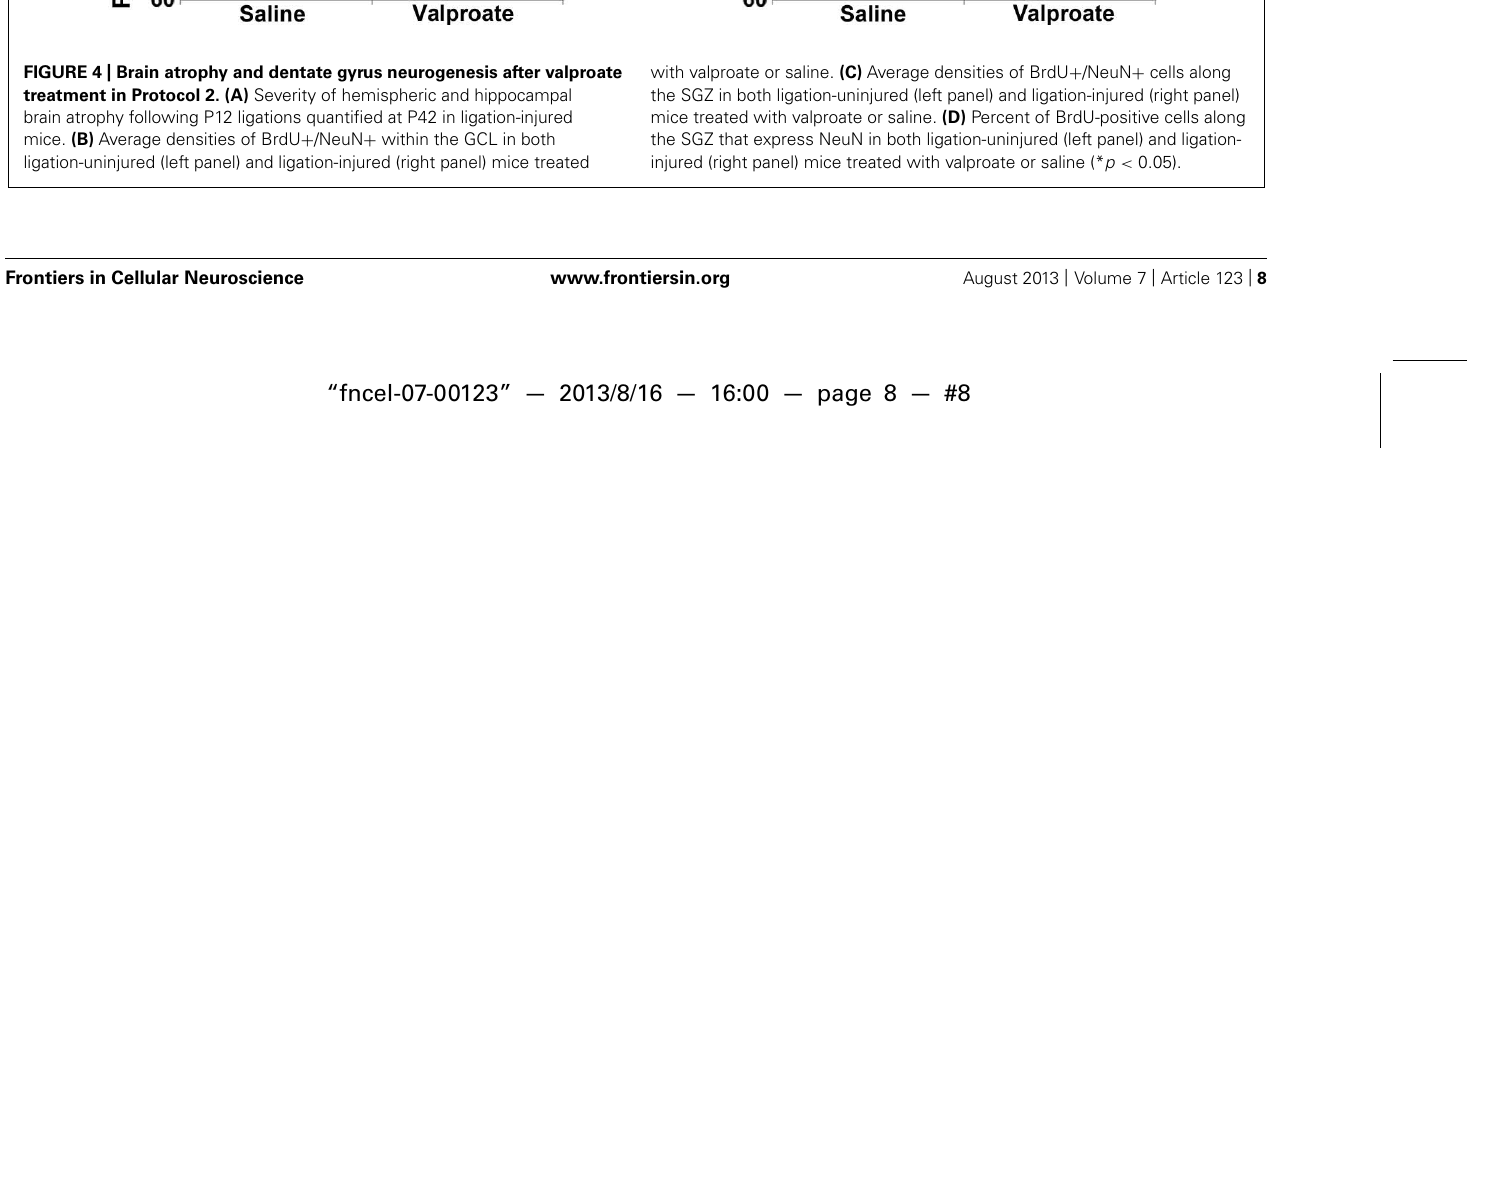
with valproate or saline. (C) Average densities of BrdU + /NeuN + cells along the SGZ in both ligation-uninjured (left panel) and ligation-injured (right panel) mice treated with valproate or saline. (D) Percent of BrdU-positive cells along the SGZ that express NeuN in both ligation-uninjured (left panel) and ligation- injured (right panel) mice treated with valproate or saline (* p <